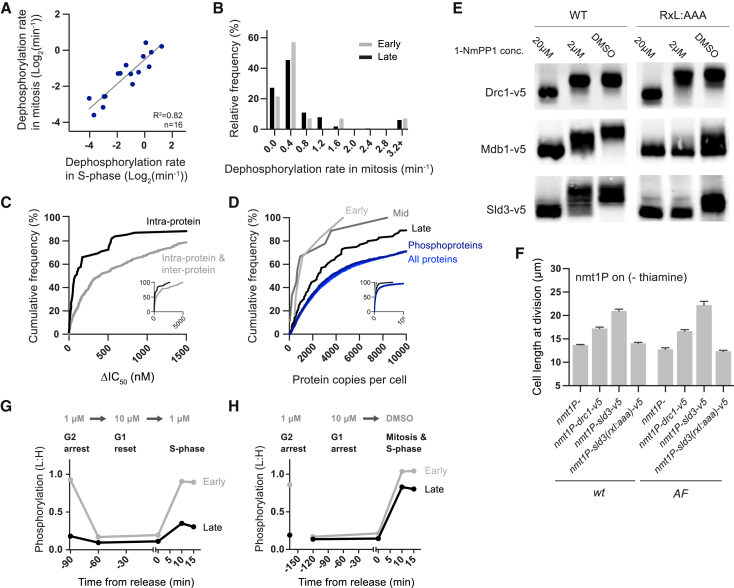
CDK Substrate Dephosphorylation Rates, Cyclin-Docking Motifs, and Substrate Phosphorylation during Reordered Cell-Cycle Experiments(A and B) Dephosphorylation rates. (A) Plot of the CDK substrate site dephosphorylation rates after CDK inactivation in S phase against in mitosis. Three phosphosites with values < 15 s were excluded. (B) Histogram of the relative frequency of dephosphorylation rates after CDK inactivation in mitosis for early and late CDK substrate sites. See also Figures S3K and S3L. See Figure S1A for experimental design. See STAR Methods for details of dephosphorylation rate calculation.(C) The cumulative frequency of the difference between the 1-NmPP1 IC50 values (ΔIC50) for all phosphosite pairs (inter- and intra-protein comparisons, n = 1711) and phosphosite pairs in the same protein (intra-protein comparisons, n = 62). ΔIC50 values were only calculated for pairs of phosphosites from substrates with more than one phosphosite IC50 value. ΔIC50 populations are significantly different (p < 0.001, two tailed Mann-Whitney U test).(D) The cumulative frequency of the protein copies per cell (Marguerat et al., 2012) for early (n = 6), mid (n = 9), and late (n = 100) CDK substrates; all phosphoproteins detected in this study (n = 1209); and all proteins (n = 3301). 178 values are above the axis limit.(E) Western blot analysis of candidate early substrate (Sld3, Drc1, and Mdb1) phosphorylation. Phosphorylation is monitored by mobility shift. Wild-type (WT) and putative cyclin docking motif mutant (RxL:AAA) versions of Drc1, Mdb1, and Sld3 were analyzed after release into DMSO, 2 μM or 20 μM 1-NmPP1 (MS306-311). See Figure S3E for experimental design.(F) Cell length at division (mean + SEM, n = 50) after Drc1, Sld3, or Sld3(RxL:AAA) overexpression in wt or checkpoint-insensitive AF strains. See also Figures S3M–S3O.(G and H) Median relative phosphorylation of early and late CDK substrate sites during two reordered cell cycles. Cell cycle stages and 1-NmPP1 concentrations are denoted above the graphs. See also Figures S4, S5, and S6. See Figure S4A for experimental design.